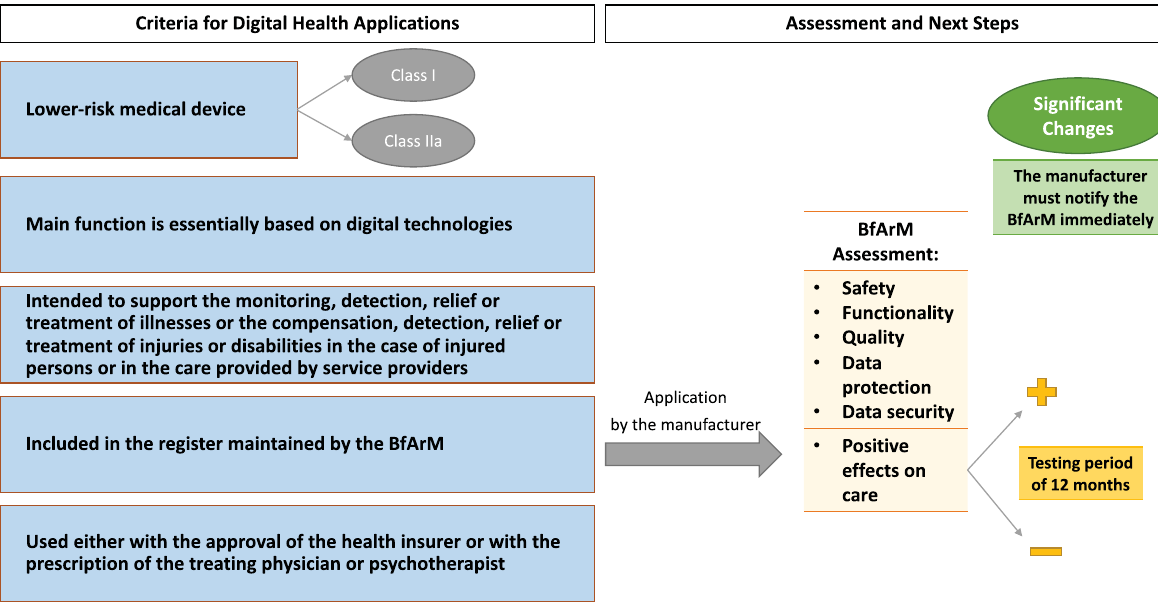
Fig. 1 Overview of the Criteria and Assessment Process for Digital Health Applications under the German Digital Healthcare Act (DVG). Criteria for digital health applications (left column) and assessment by the BfArM to be included in the register and next steps (right column).